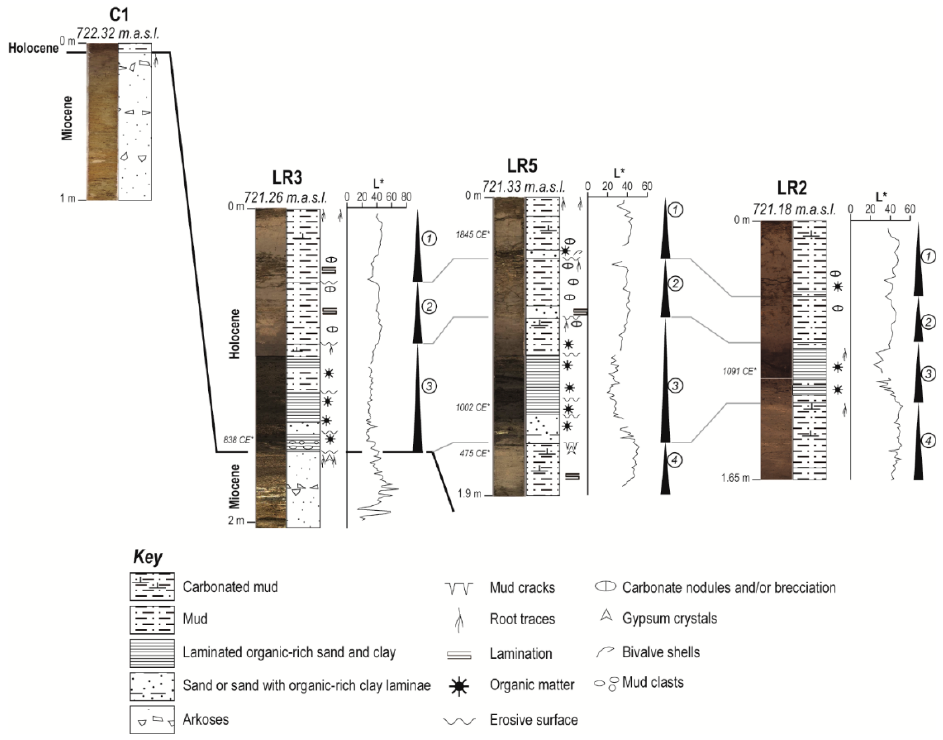
Figure 3. Stratigraphic sections for cores C1, LR2, LR3 and LR5 placed at their respective heights. Lightness (L*) is represented as indicative of the darker, organic-rich